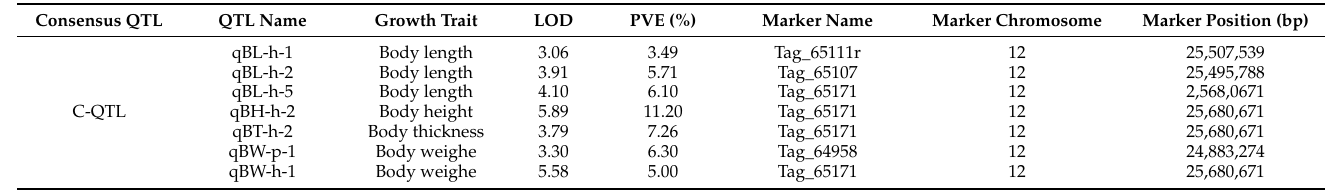
Table 6. Information on the consensus QTL in Yellow River carp at 5–9 months after hatching.